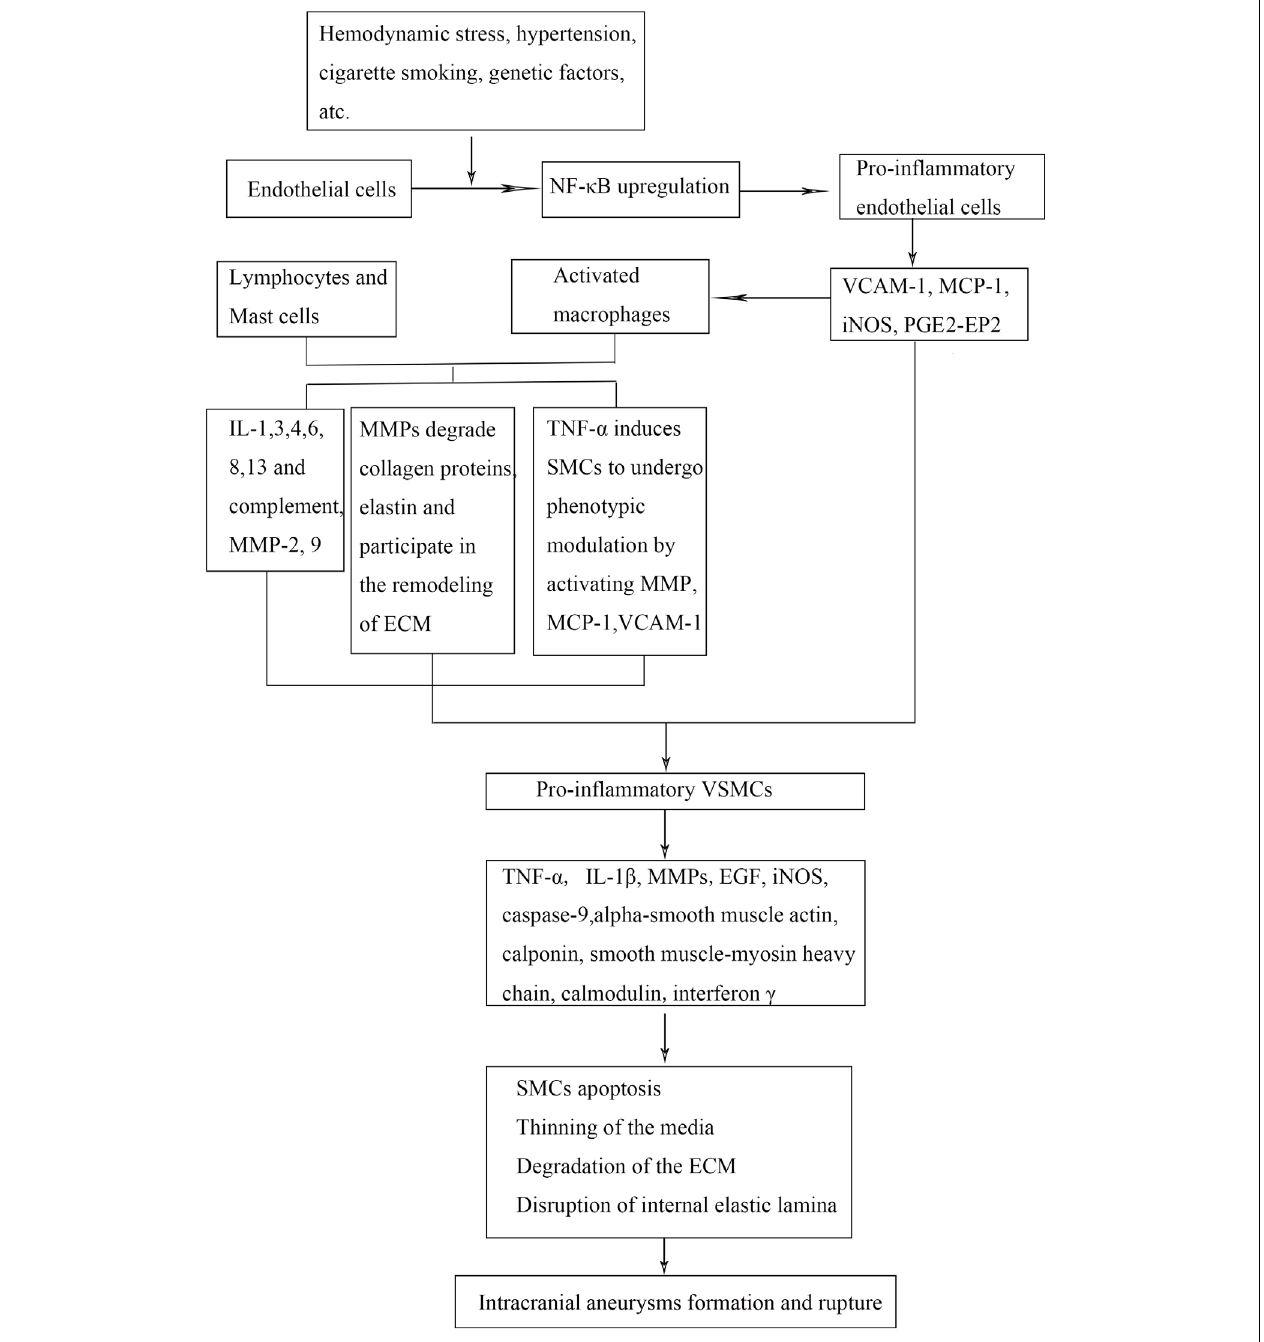
FIGURE 2 | Mechanistic flow chart of IA pathobiology. Abnormal wall sheer stress on the endothelial cells (ECs) causes release of inflammatory mediators that recruit inflammatory cells into the damaged vessel walls. Smooth muscle cells undergo phenotypic modulation and apoptosis, which lead to breakdown of the surrounding extracellular matrix. These events lead to weakening of the arterial wall, aneurysm formation, and rupture. NF- κ B indicates nuclear factor- κ B; VCAM-1, vascular cell adhesion molecule 1; MCP-1, monocyte chemoattractant protein 1; iNOS, inducible nitric oxide synthase; IL, interleukin; TNF- α , tumor necrosis factor α ; MMP, matrix metalloproteinase; PGE 2 –EP 2 , prostaglandin E 2 –E receptor 2; VSMCs, vascular smooth muscle cells; ECM, extracellular matrix; IA, intracranial